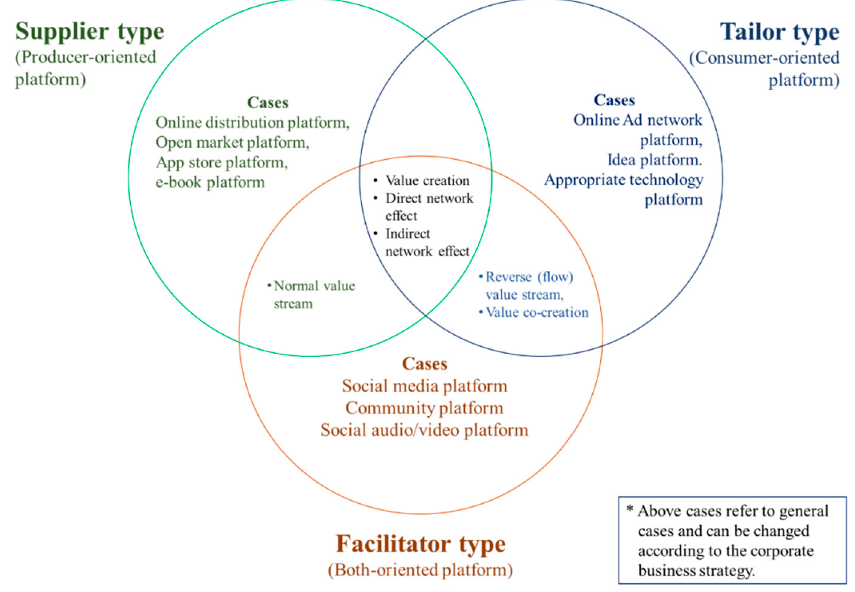
Figure 3. Three types of platform business model in accordance with the value